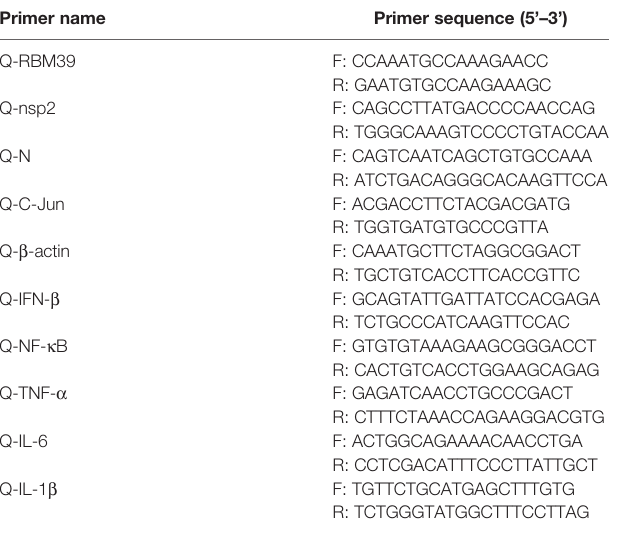
TABLE 2 | Primers used in quantitative real-time PCR.